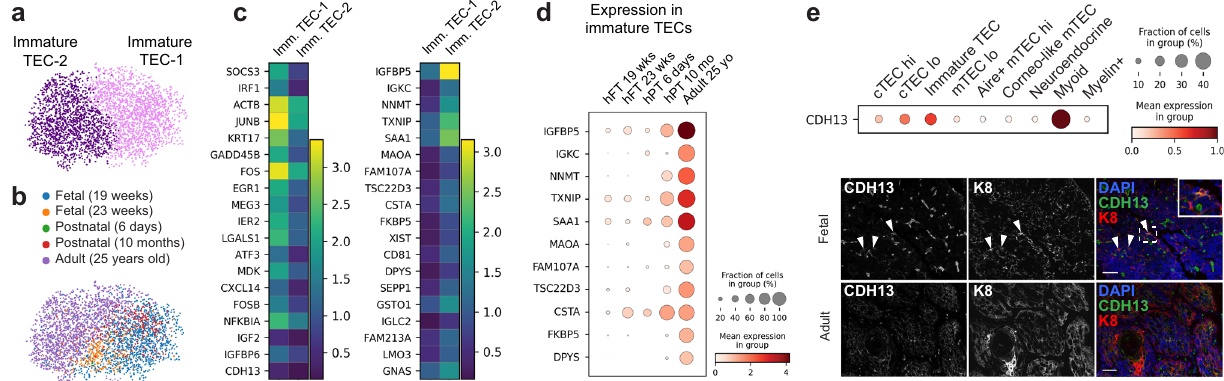
Fig. 3 Analysis of immature TECs. a , b UMAP visualization of immature TECs colored by cell type ( a ) or age ( b ). c Heatmap showing the expression of marker genes in each immature TEC (imm. TEC) cluster. d Dot plot of immature TEC gene expression in human fetal thymus (hFT), human postnatal thymus (hPT), or adult thymus. e Expression of CDH13 in epithelial subsets was con fi rmed by immuno fl uorescence analysis of human fetal thymus and human adult thymus. Scale bars, 50 μ m. Staining was repeated three times with similar results.